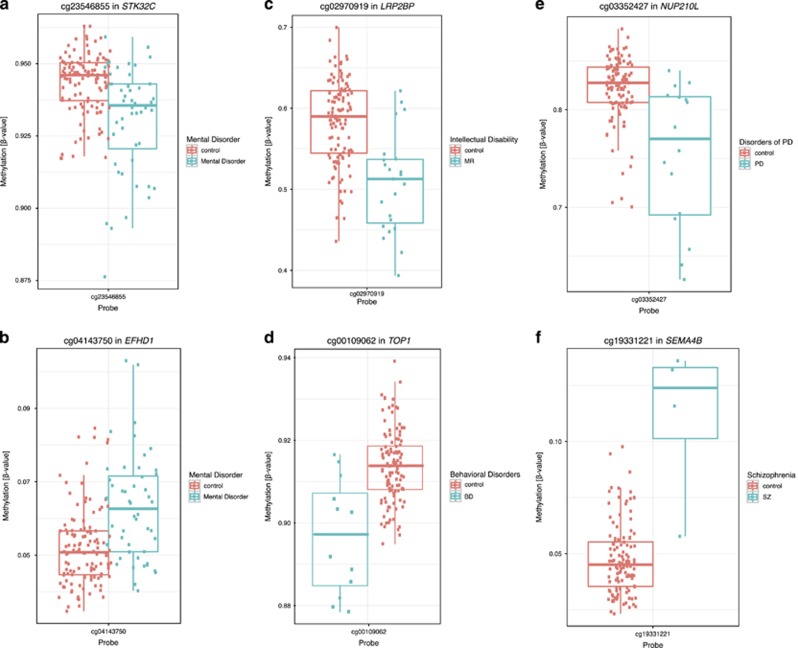
Overview of DNA methylation values for the highly associated CpG sites in EWAS of psychiatric diagnosis, site in STKC32 (P-value=2.15 × 10−7; a) and in EFHD1 (P-value=7.39 × 10−7; b); intellectual disability, site in LRP2BP (P-value=5.37 × 10−8; c); behavioral disorders, site in TOP1 (P-value=1.86 × 10−7; d); disorders of psychological development, site in NUP210L (P-value=1.67 × 10−8; e); schizophrenia, site in SEMA4B (P-value=4.02 × 10−7; f). EWAS, Epigenome-Wide Association Study.